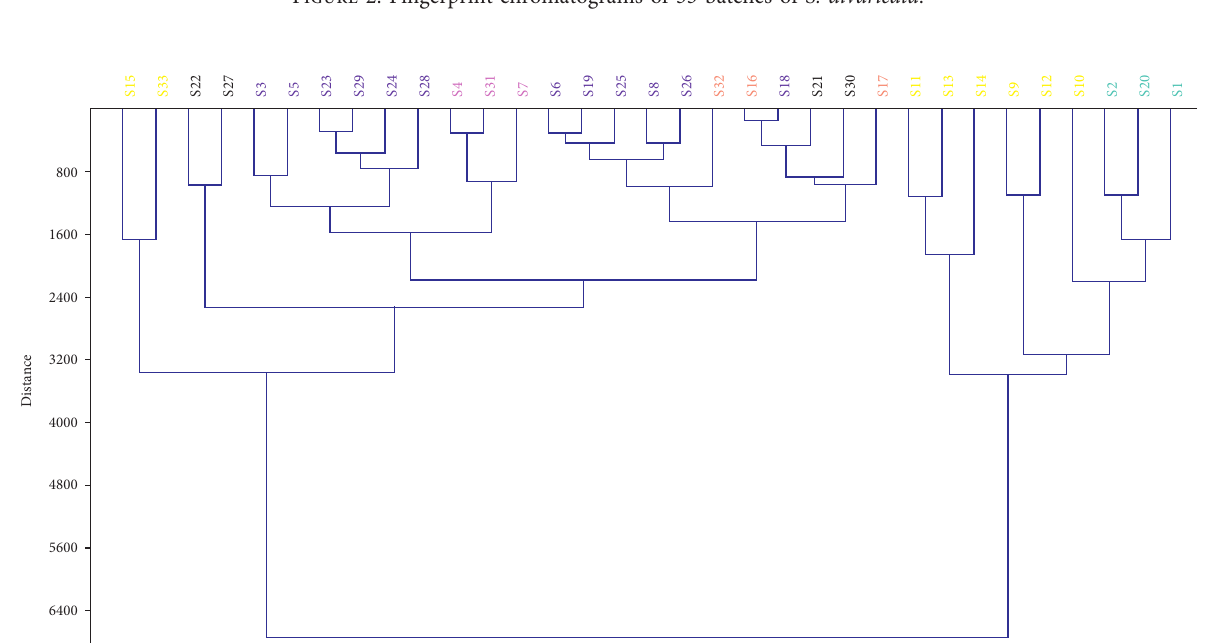
Figure 2: Fingerprint chromatograms of 33 batches of S. divaricata .